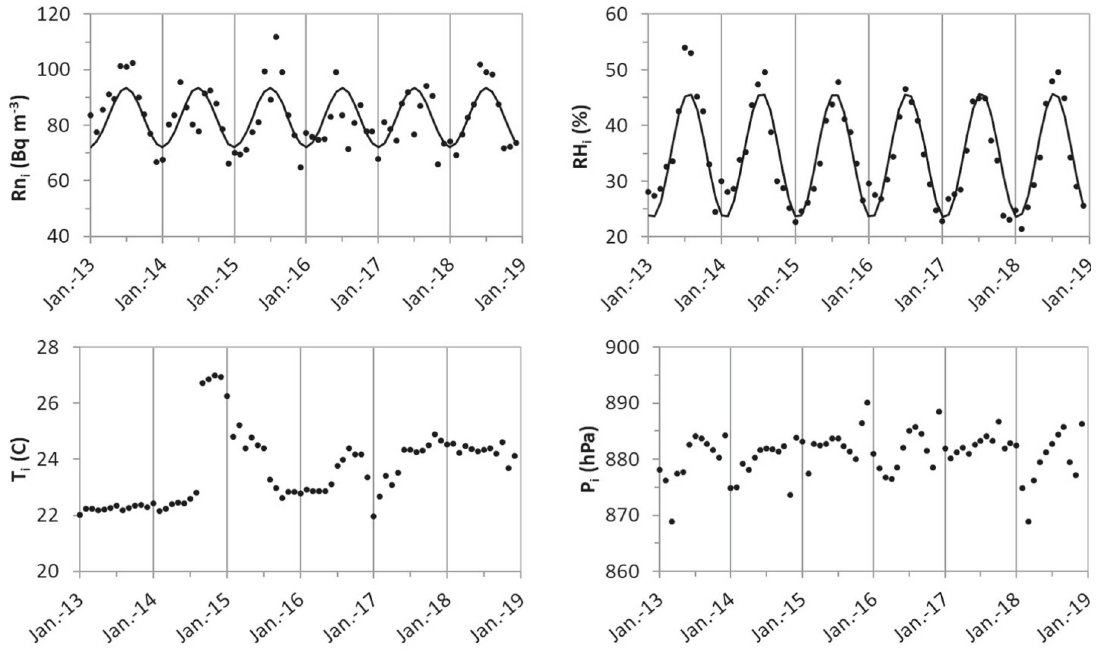
Fig. 2 Monthly average of the hall A data: 222 Rn concentration (upper left), relative humidity (upper right), temperature (bottom left) and atmospheric pressure (bottom right) from January 2013 to December